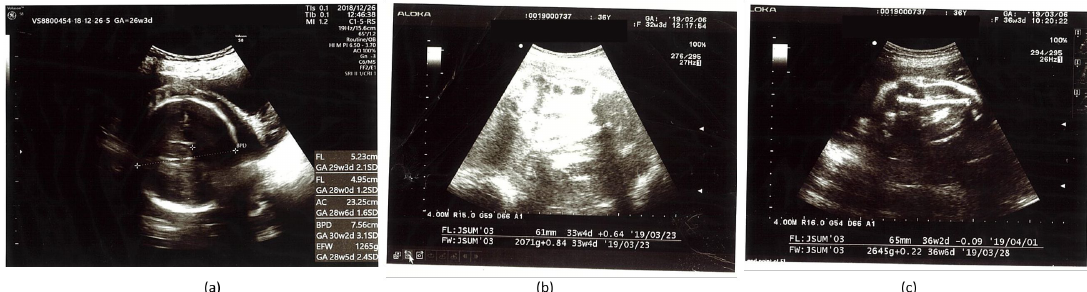
Figure 2. Changes in fetal measures after dietary modifications and intermittent fasting. As shown in panel ( a ) hyperglycemia caused all fetal parameters to be significantly greater (ranging between 28 weeks to 30 weeks) than the real gestational age (26 weeks). Exercise and caloric restriction remarkably ameliorated fetal weight gain resulting in an almost normal fetal weight, panel ( b ). Intermittent fasting in addition to caloric restriction and physical activity resulted in a normal fetal weight, panel ( c ). Most other fetal growth measures tended to be within normal range (Table 1). Pictures were edited to remove patient’s identifying